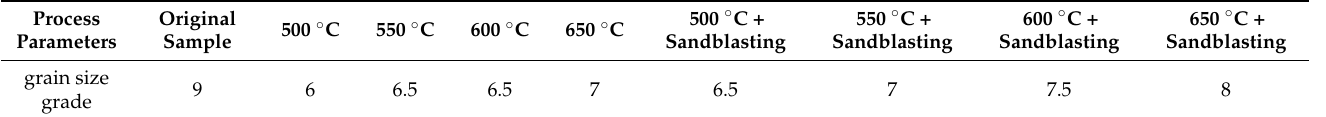
Table 4. Grain size grade of the WZ under different processes.